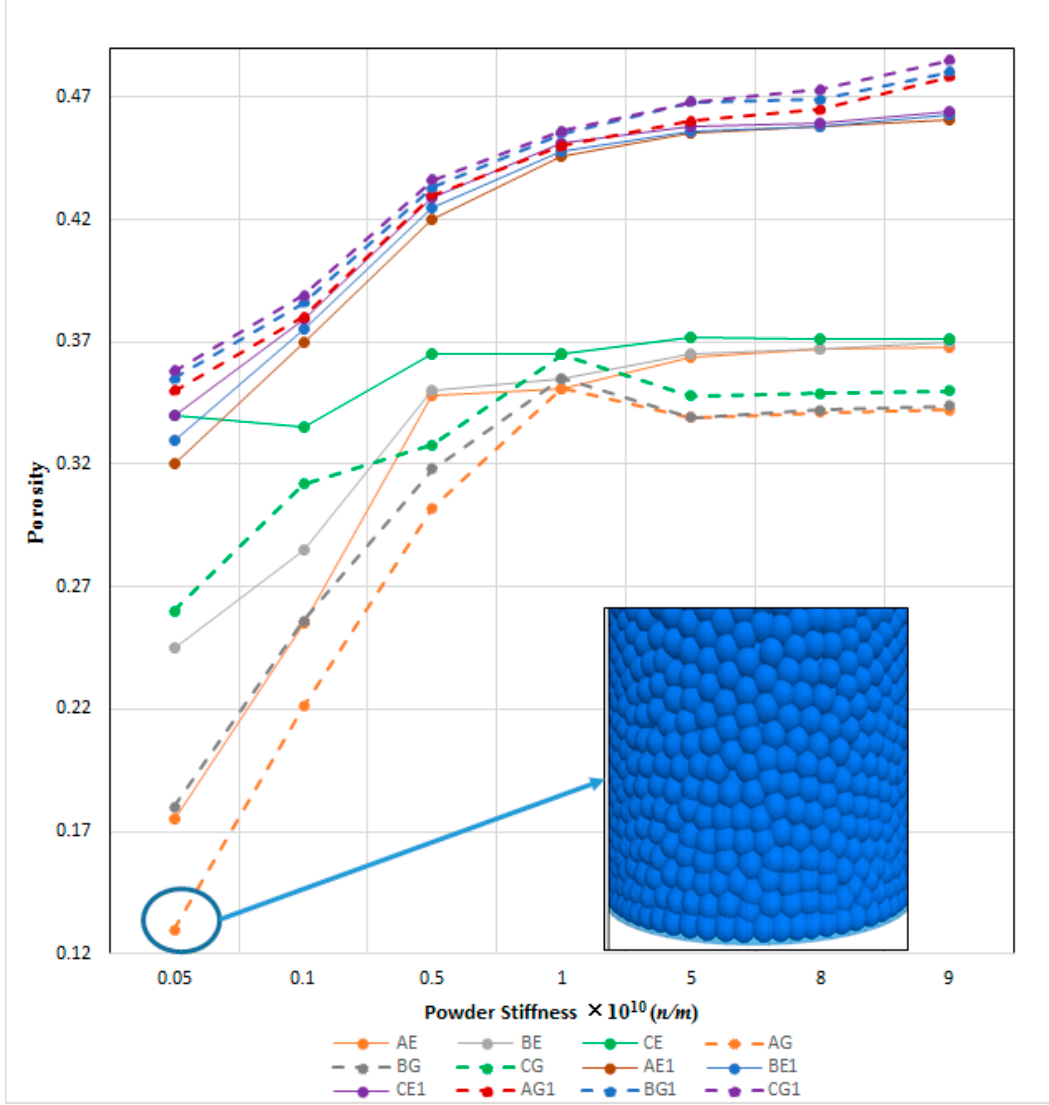
Figure 5. Porosity at different depths in container for mono-size particles and Gaussian size-distributed particles with different powder stiffnesses (E refers to the packing porosity for particles with a single size, and G represents the packing porosity for particles with a Gaussian size